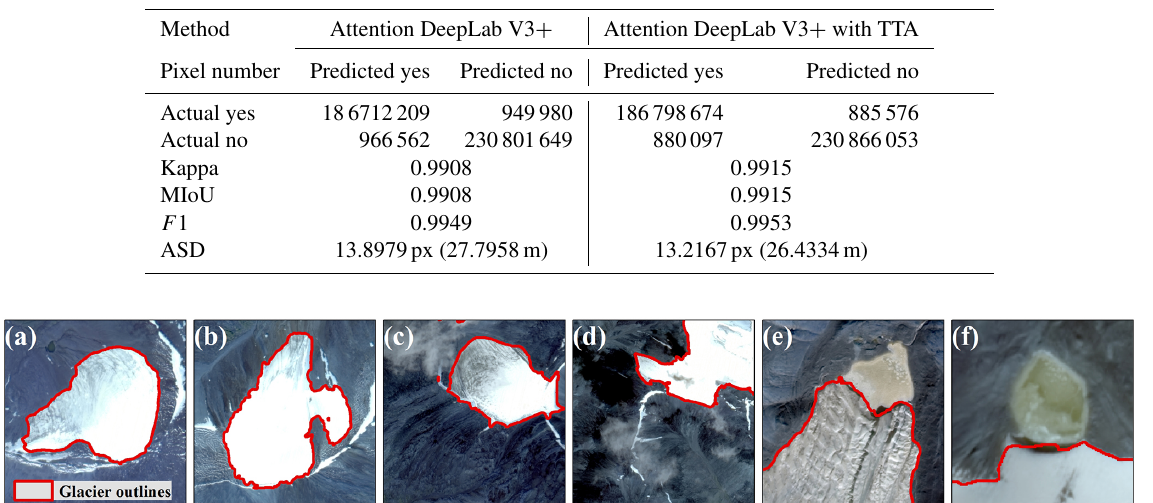
Table 2. Confusion matrix of test set results.